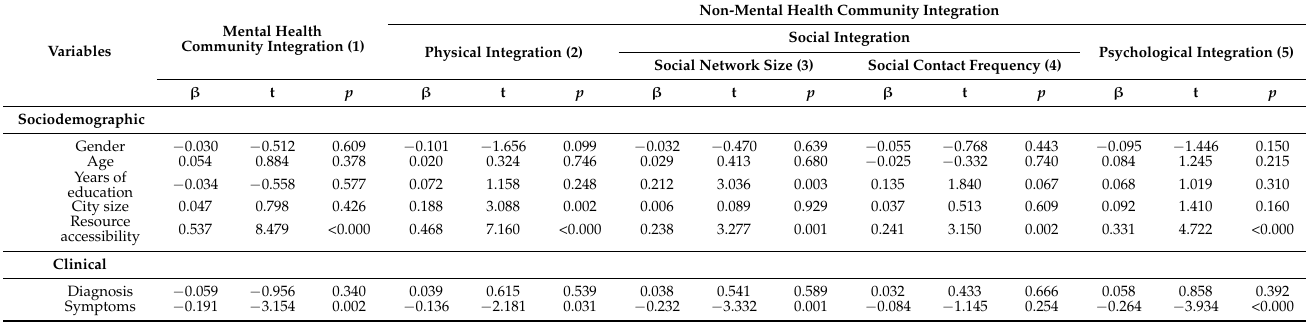
Table 2. Effectsofsociodemographicandclinicalvariablesonintegrationintothementalhealthandnon-mentalhealthcommunities. MentalHealth CommunityIntegration(1) Variables